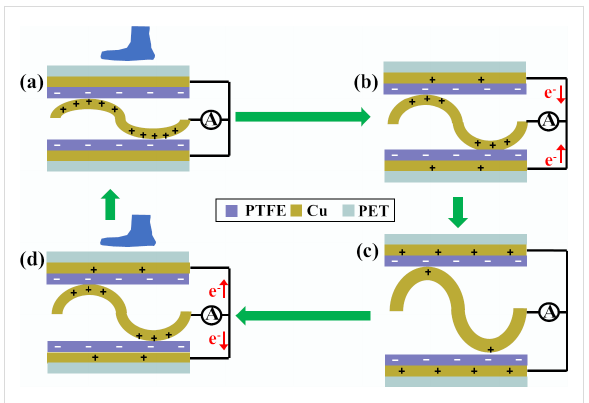
Figure 2: The working mechanism of the fabricated u-TENG in response to a stepping force. (a) The PTFE film and the undulated Cu electrode are brought into intimate contact by an external applied force. (b) When the force is released, free electrons flow from the Cu planar electrode to the undulated electrode. (c) The u-TENG reverts back to its unloaded position. (d) An external force compresses